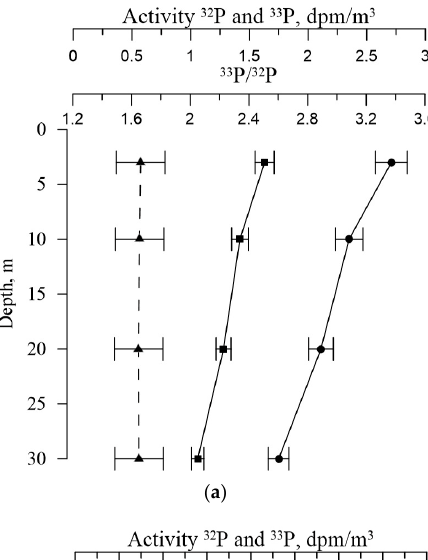
Figure 5. Values of 32 P and 33 P activity and 33 P/ 32 P ratio in seawater for different horizons: ( a ) winter 2021; ( b ) spring 2022; ( c ) summer 2022, ( d ) autumn 2022 ( 32 P ( ■ ), 33 P ( ● ), 33 P/ 32 P ratio ( ▲ )).